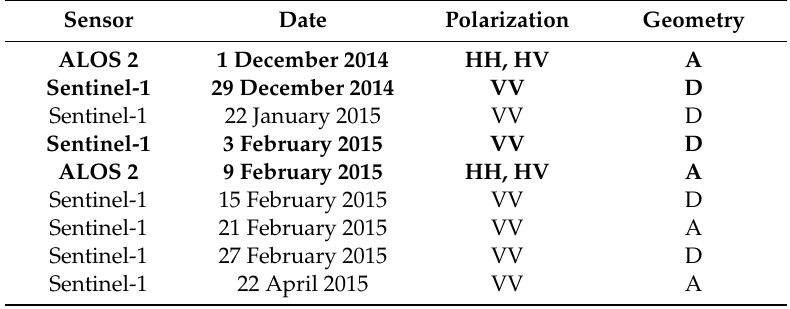
Table 1. Details on the used imagery. A = ascending, D = descending geometry. Images indicated in red bold text color are those selected for the subsequent multi-frequency